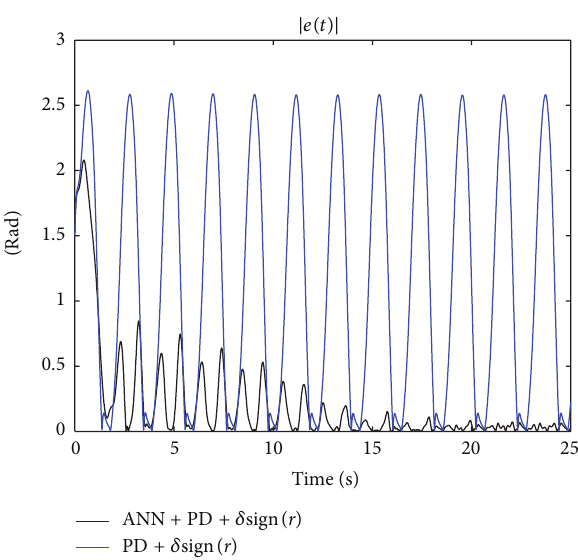
Figure 12: Experiments with the one degree-of-freedom robot: absolute value of tracking error |𝑒(𝑡)| for the PD + 𝛿 sign (𝑟) and the ANN + PD + 𝛿 sign (𝑟)